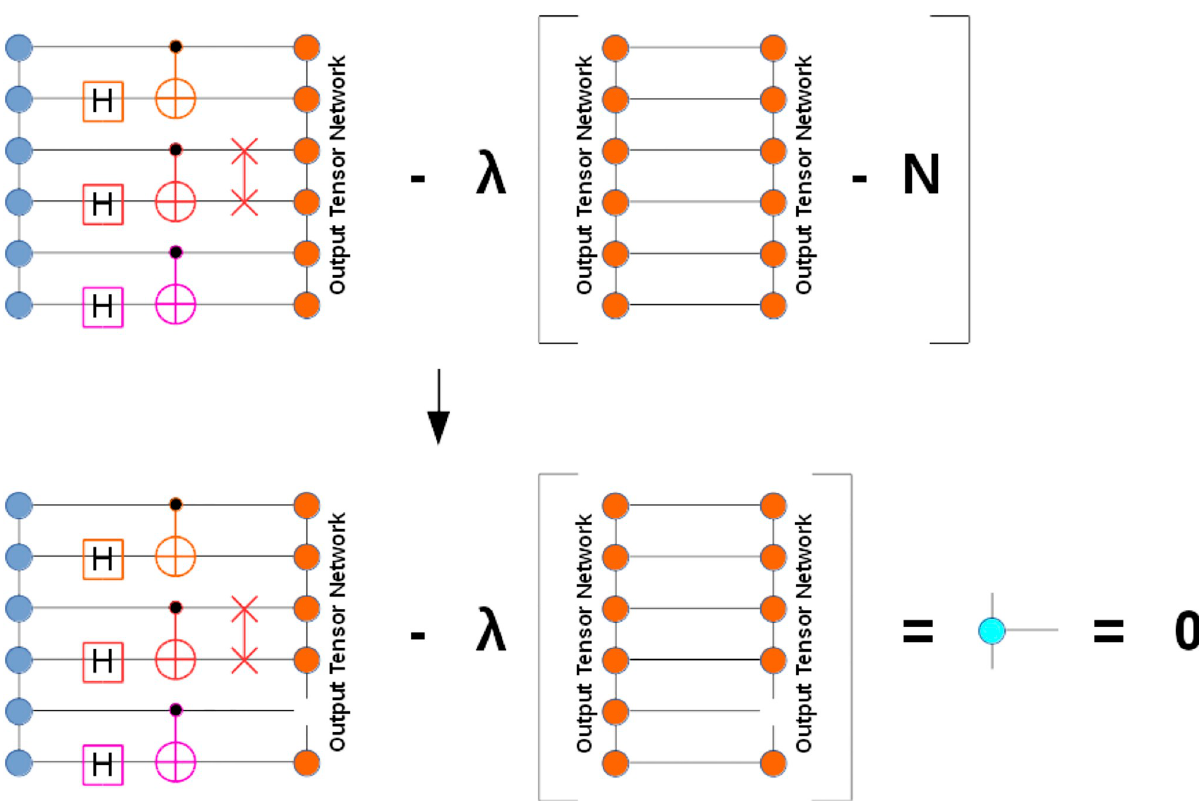
Fig 4. Graphical illustration of the constrained optimization problem for the output MPS tensor network with a simple constraint of normalization to N. In general, additional constraints can apply to the tensor network factors, for example requirement of isometry or unitarity (see Ref. [40]).